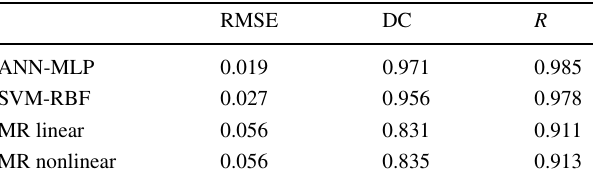
Table 6 ANN, SVM, MR linear, and MR nonlinear results for the